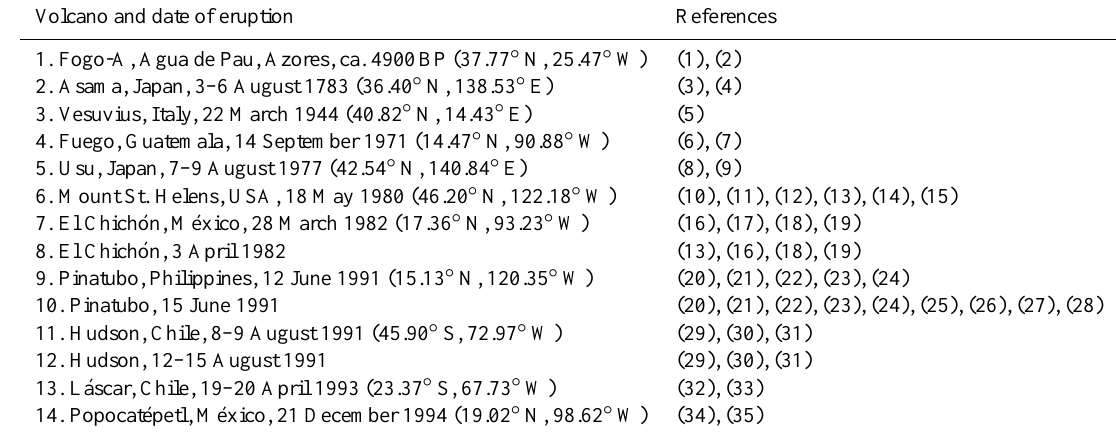
Table 1. Eruptions used as a reference to study the spatial distribution of ashfall deposits as a function of eruptive intensity, duration and wind conditions. Volcano and date of